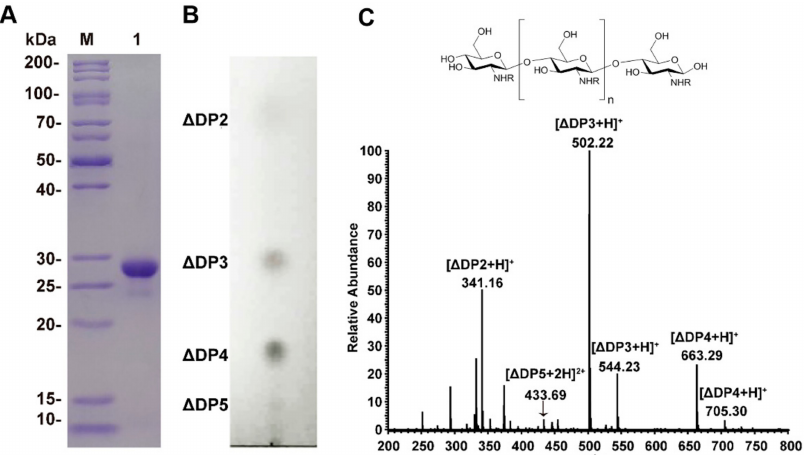
Figure 1. Analysis of purified CsnA and chitosan oligosaccharides. ( A ) SDS-PAGE analysis of CsnA. Lane M, protein molecular mass marker; Lane 1, purified CsnA. ( B ) TLC analysis of the hydrolysis product of CsnA. ( C ) The chemical structure and MS analysis of chitosan oligosaccharides. ‘R’ can be either H or acetyl group depending on the DP. DP2, (GlcN) 2 ; DP3, (GlcN) 3 and (GlcN) 2 (GlcNAc) 1 ; DP4, (GlcN) 4 and (GlcN) 3 (GlcNAc) 1 ; DP5, (GlcN) 4 (GlcNAc) 1 ; GlcN—2-amino-2-deoxy- d